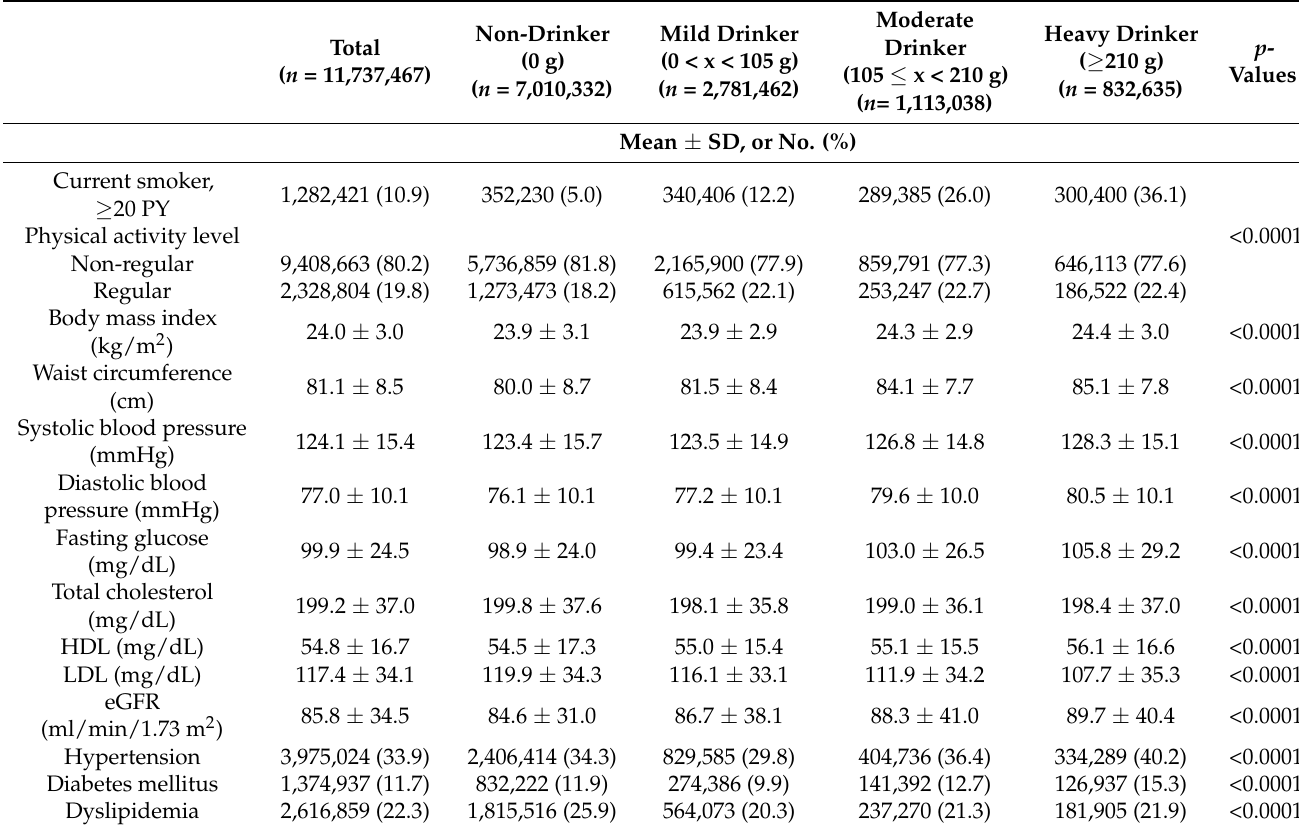
Table 1. Baseline characteristics according to average weekly alcohol